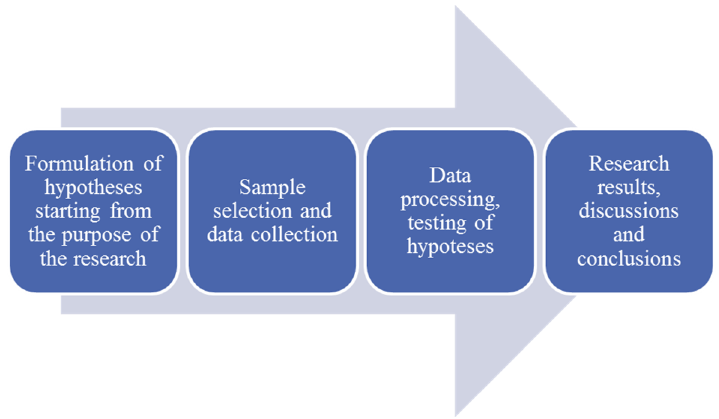
Figure 2. Research process. Source: own construction.